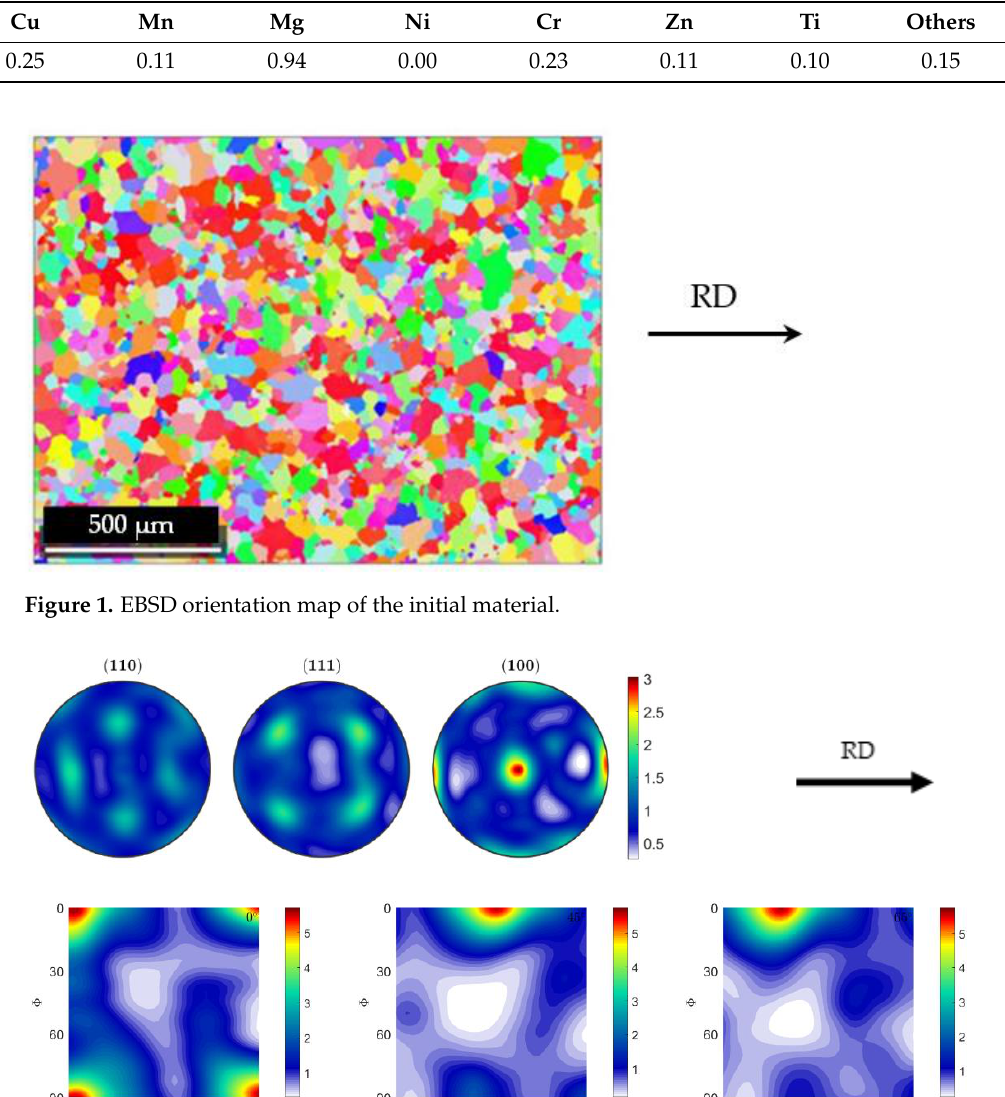
Table 1. Chemical composition of the material as-received wt.%.